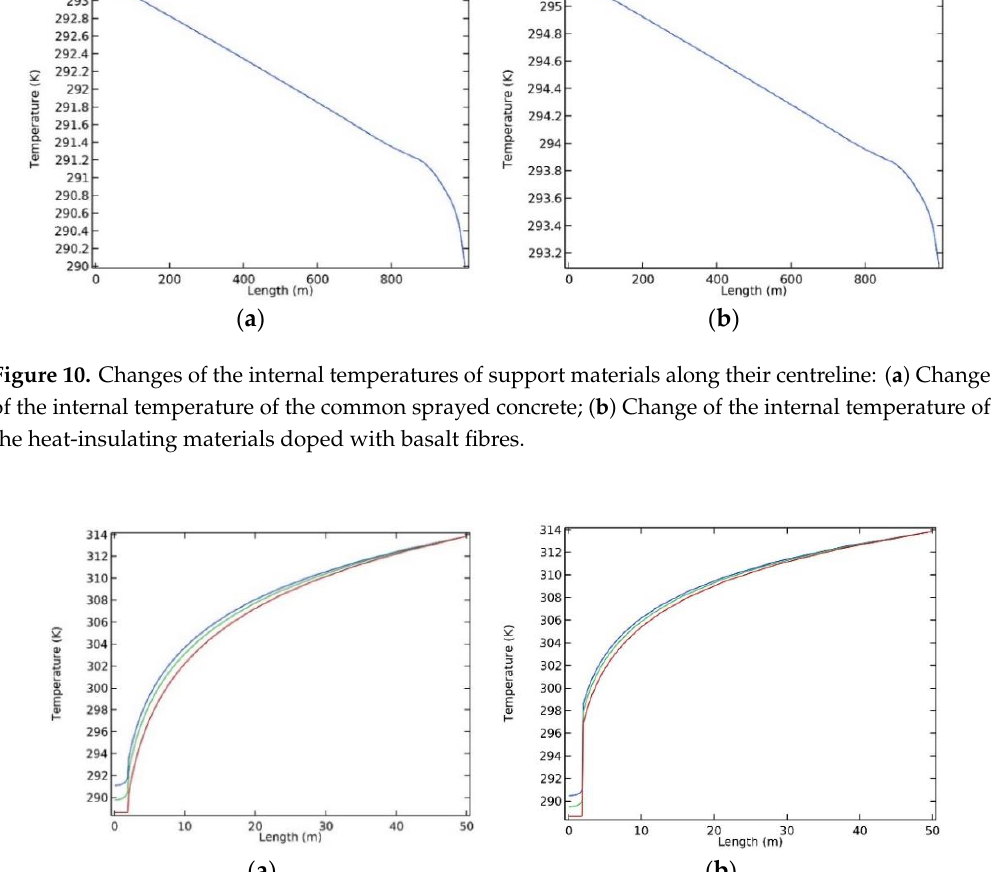
Figure 11. Statistics pertaining to the temperature distributions in the materials: ( a ) The temperature of the common sprayed concrete; ( b ) The temperature of the heat-insulating materials doped with basalt